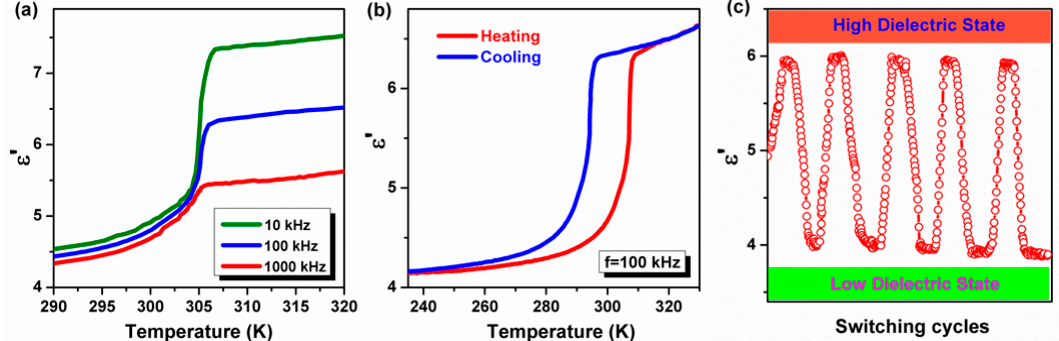
Figure 3. ( a ) Temperature-dependence of the real part ( ε ') of the polycrystalline sample for 1 at selected frequencies in the heating run. ( b ) Temperature-dependence of the real part ( ε ') of the polycrystalline sample for 1 at 100 kHz in the heating-cooling run. ( c ) The recoverable switching of dielectric effects of compound 1.